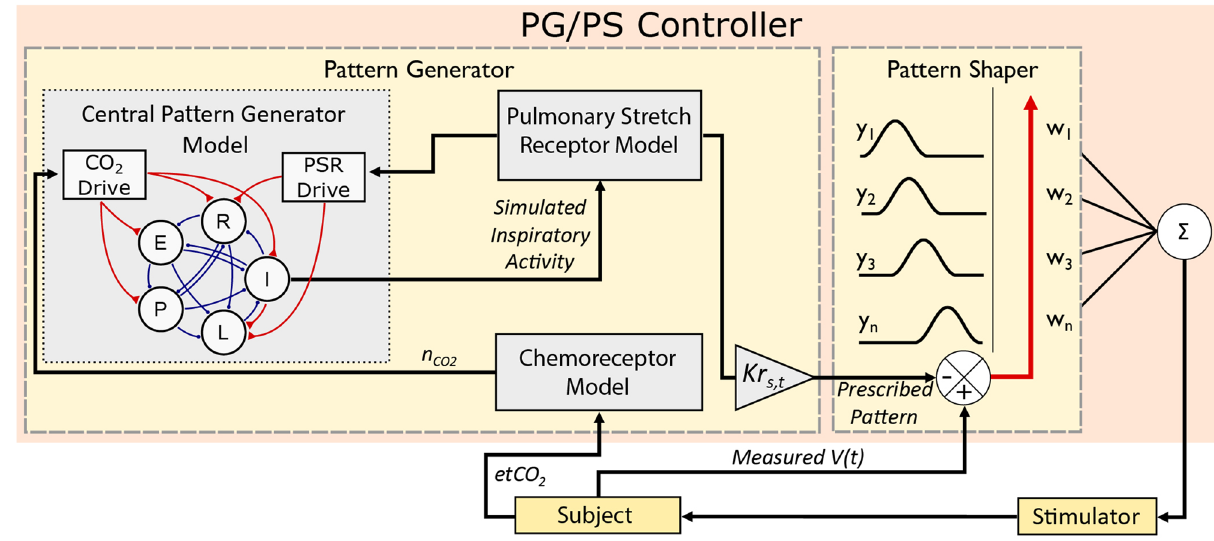
Figure 2. Pattern generator/pattern shaper adaptive controller block diagram. A Pattern Generator (PG) is used to prescribe a ventilatory pattern and a Pattern Shaper (PS) is used to determine the stimulation required for pacing of the diaphragm to attain the prescribed pattern. The PG integrates a computational model of the respiratory central pattern generator (rCPG) 19 , a pulmonary stretch receptor (PSR) model, and a CO 2 chemoreceptor model to generate a ventilatory response, which is scaled in amplitude by a factor Kr s and in time by a nominal factor Kr t to prescribe a breath volume profile to be elicited. The PS derives a volume-based error measure used to continuously modulate network weights w n , which ultimately help define the amplitude of the stimulation delivered to the diaphragm. Changes in PaCO 2 due to changes in ventilation are reflected in changes in etCO 2 . The chemoreceptor model converts etCO 2 to neural CO 2 drive nCO 2 which modulates activity within the rCPG, generating a new inspiratory pattern and closing the control loop. Breath volume at time t, V(t) ; partial pressure of arterial CO 2 , PaCO 2 ; end-tidal CO 2 , etCO 2 ; Neural CO 2 drive from chemoreceptor, nCO 2 ; Kr s amplitude scaling factor; Kr t duration scaling